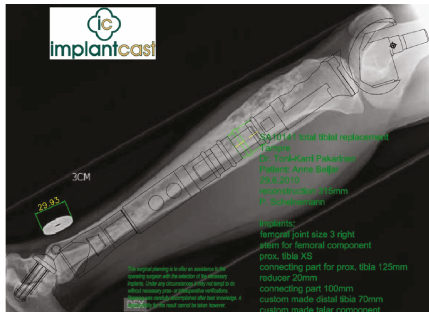
Figure 2: The preoperative planning of a custom-made total tibia endoprosthesis. The preoperative planning for total tibia resection and reconstruction with a custom-made, silver-coated, modular endoprosthesis of the Modular Universal Tumor and Revision System.